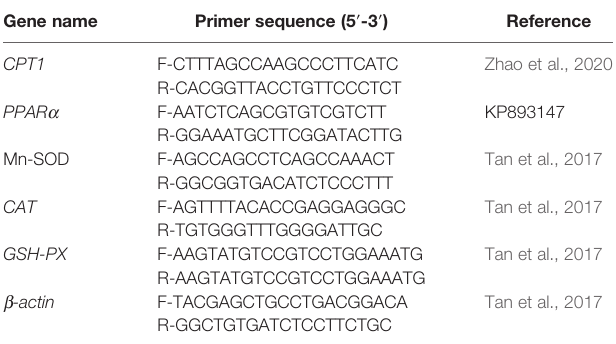
TABLE 2 | Sequences of primers used for real-time quantitative PCR.